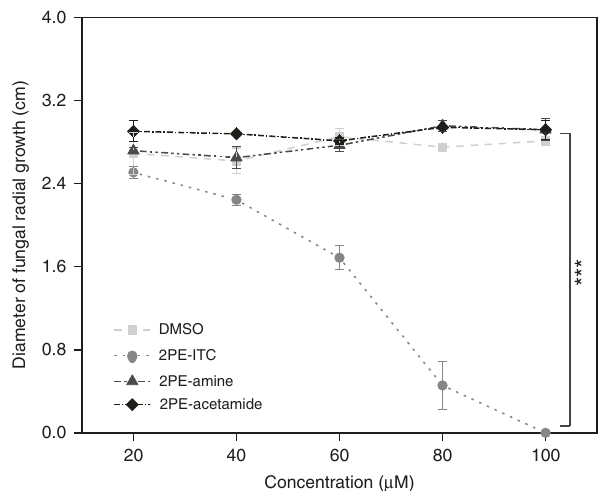
Fig. 5 2PE-ITC but not its metabolites 2PE-amine and 2PE-acetamide reduces S. sclerotiorum growth. S. sclerotiorum was grown on PDA plates amended with different concentrations of these three metabolites and the diameter of fungal radial growth was measured 24 h after co-incubation with these compounds. Data represent mean ± SEM ( n = 3 independent fungal cultures; growth assay was repeated once) and were analyzed by fi tting a linear model using ANCOVA (2PE-ITC/DMSO, 2PE-ITC/2PE- Amine and 2PE-ITC/2PE-Acetamide, *** p < 0.001). 2PE-ITC, 2-phenylethyl isothiocyanate; 2PE-Amine, 2-phenylethylamine; 2PE-Acetamide, 2- phenylethylacetamide. Source data are provided as a Source data fi